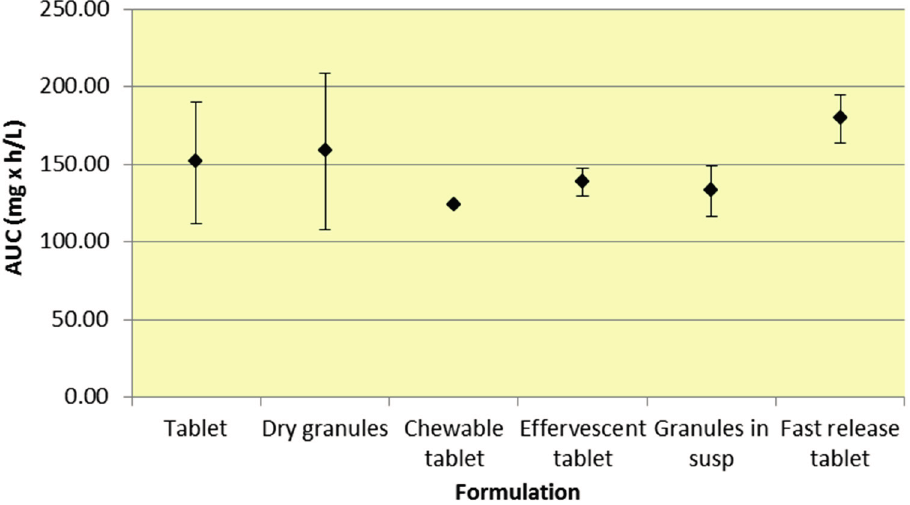
Figure 2. Summary SA AUC for various 500 mg formulations (Mean ±